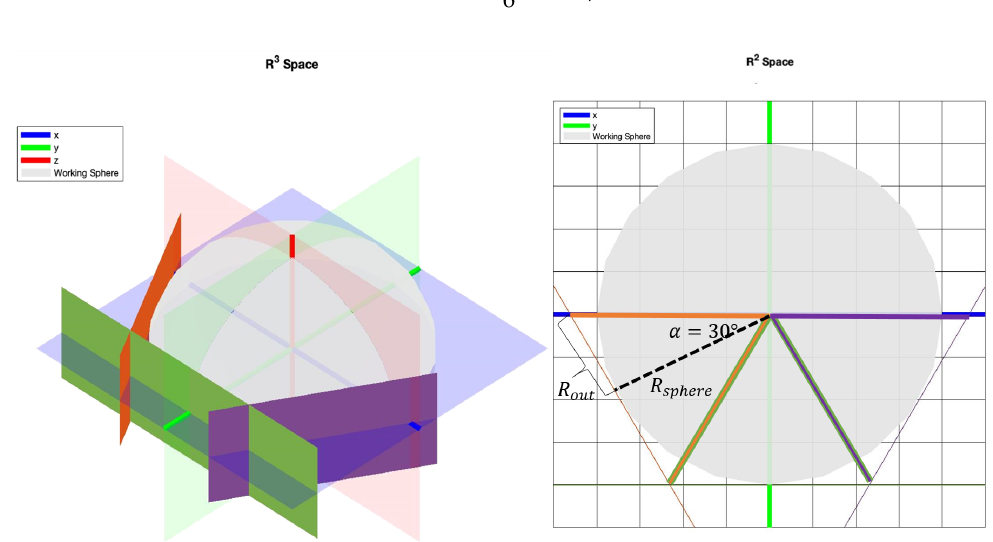
Figure 2. Working space and outer diameter of the